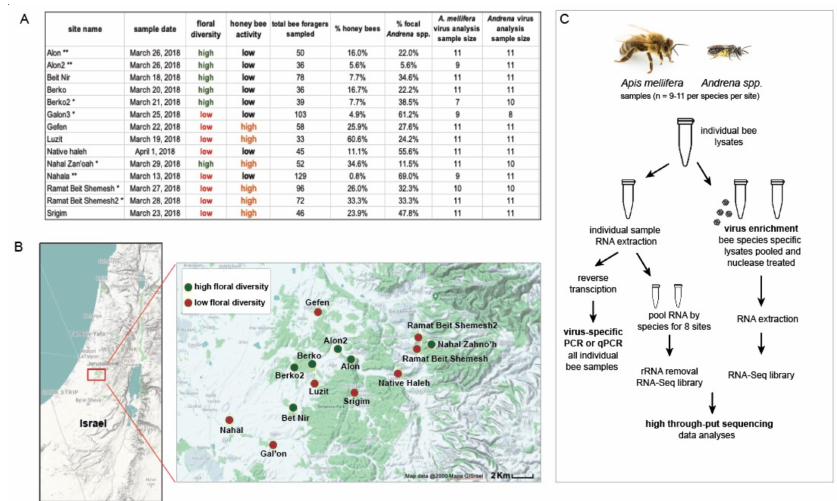
Figure 1. Overview of sampling and analysis of sympatric bee species collected from 14 sites in Israel. ( A ). The table provides a summary of the site-specific data obtained in this 2018 sample cohort. Sampling sites were selected for the survey as either high or low floral diversity, based on their floral species richness. Honey bee activity at each site was also categorized as either high or low, based on the percentage of honey bees out of the total number of bees sampled. This study resulted in the collection of over 1331 bee samples, including 263 Apis mellifera and 876 Andrena spp. samples. Assessment of viral diversity and abundance was carried out on a subset of individual bees (i.e., a median of 11 individual bees per taxon per site). ( B ). Map of Israel with sample sites labeled and marked with green and red dots indicating high and low floral diversity, respectively. ( C ). Schematic of the sample sizes and molecular